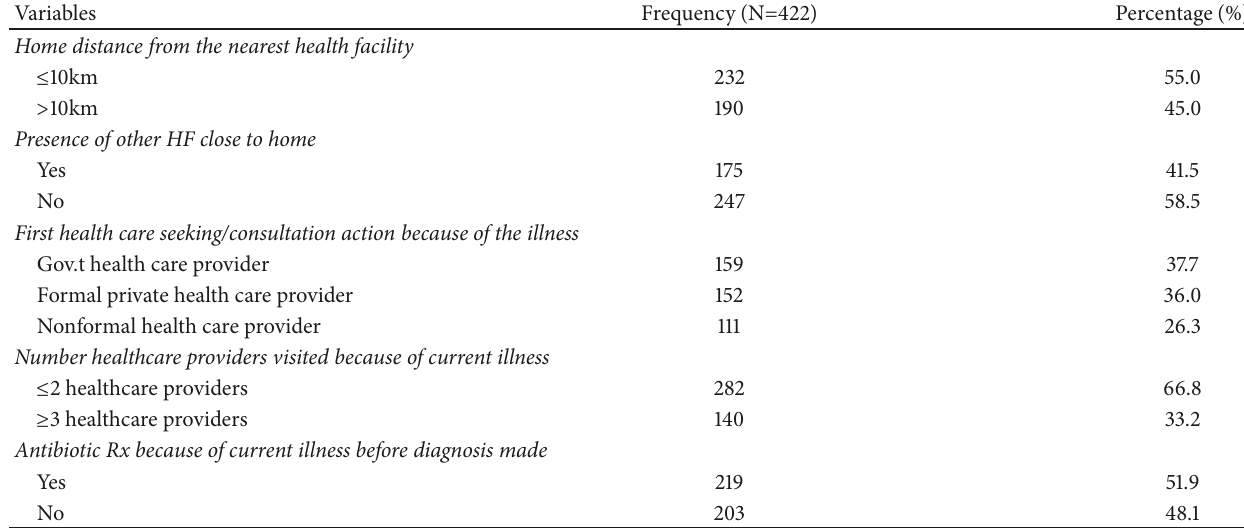
Table 4: Health accessibility & health seeking behaviors of the study participants among selected health facilities of Gedeo Zone, Southern Ethiopia,